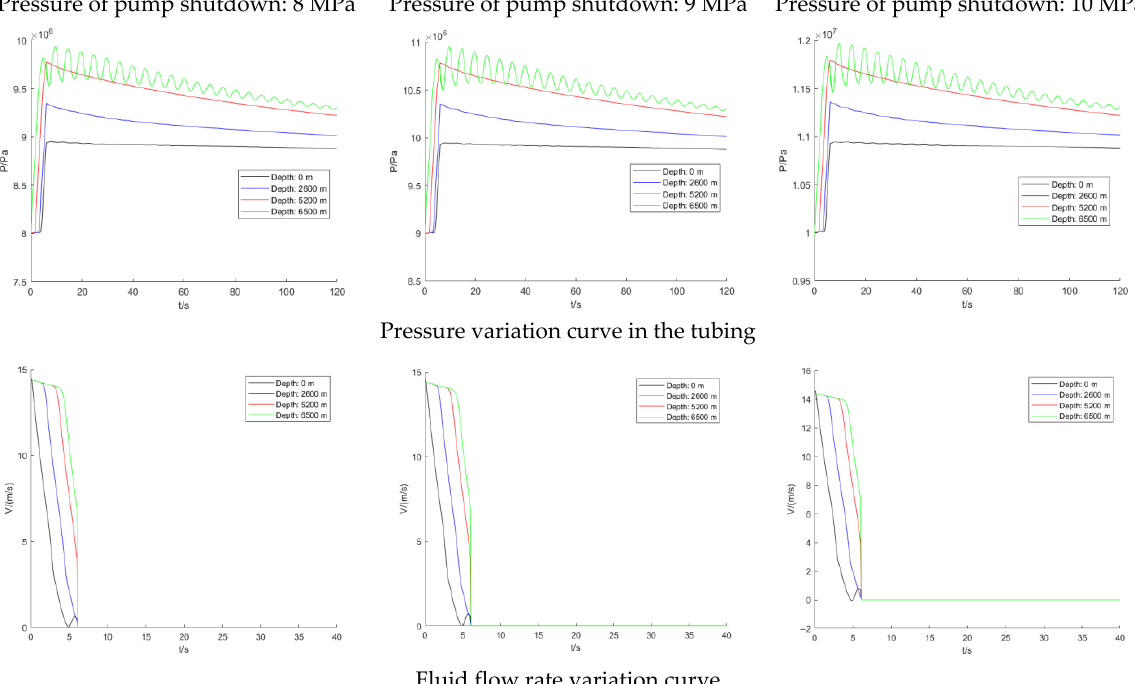
Figure 6. Variation curves of flow field parameters at different initial shutdown pressures.